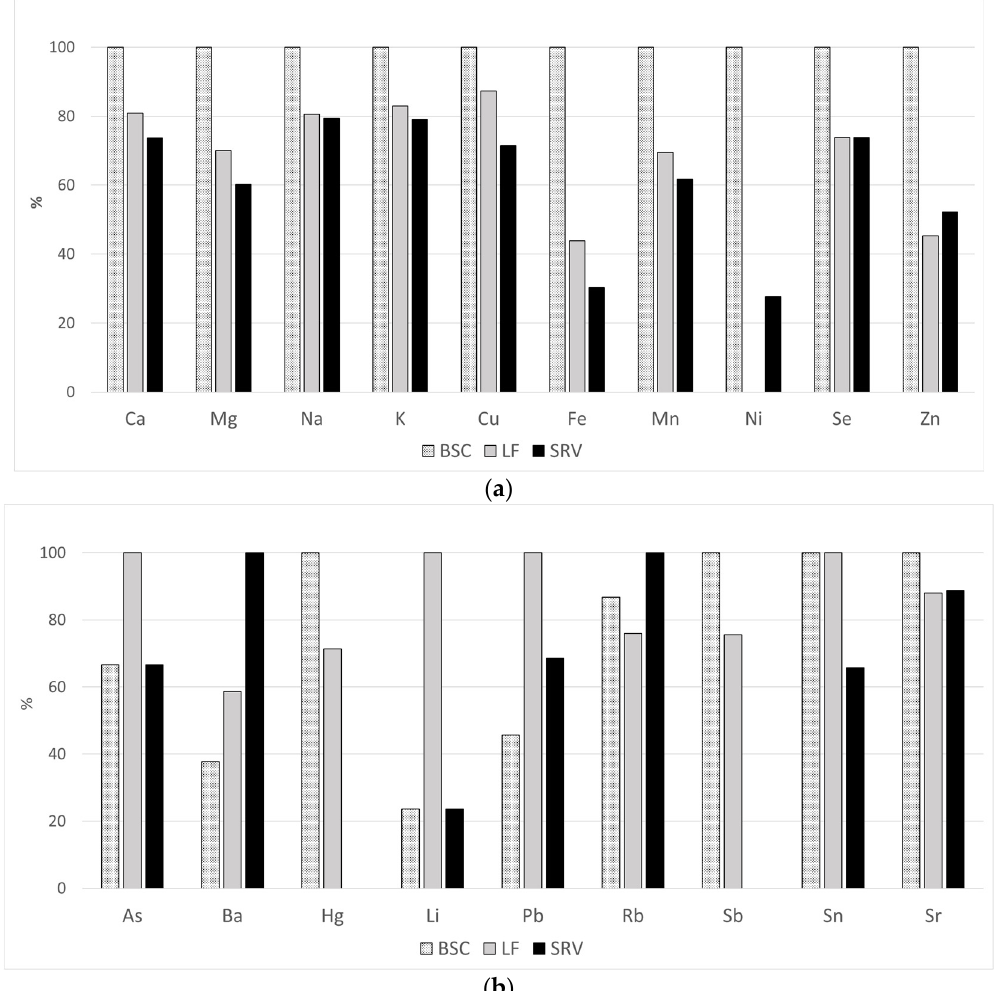
Figure 2. Percentage Elemental Relative Concentrations in semen. For each element, the percentage calculated with formula (1) of each subgroup (BSC, LF, SRV) is reported. ( a ) shows the elements defined as macro and essential ones; ( b ) shows the elements defined as additional and non-essential ones.